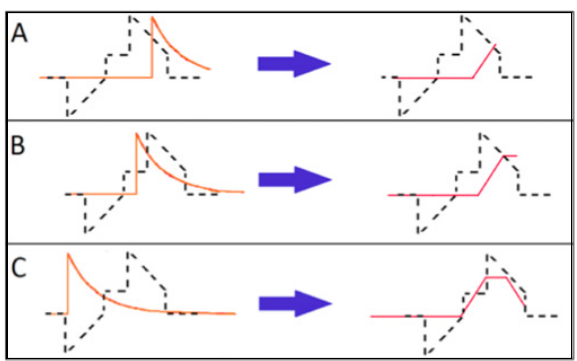
Figure 4. Example of trapezoid filter shaping response function (dashed line). The trapezoid filter input (preamplifier signal) is shown on the left (solid orange line), the output of the filter is shown on the right (solid red line). A, B, and C show the response function moving across the input function.